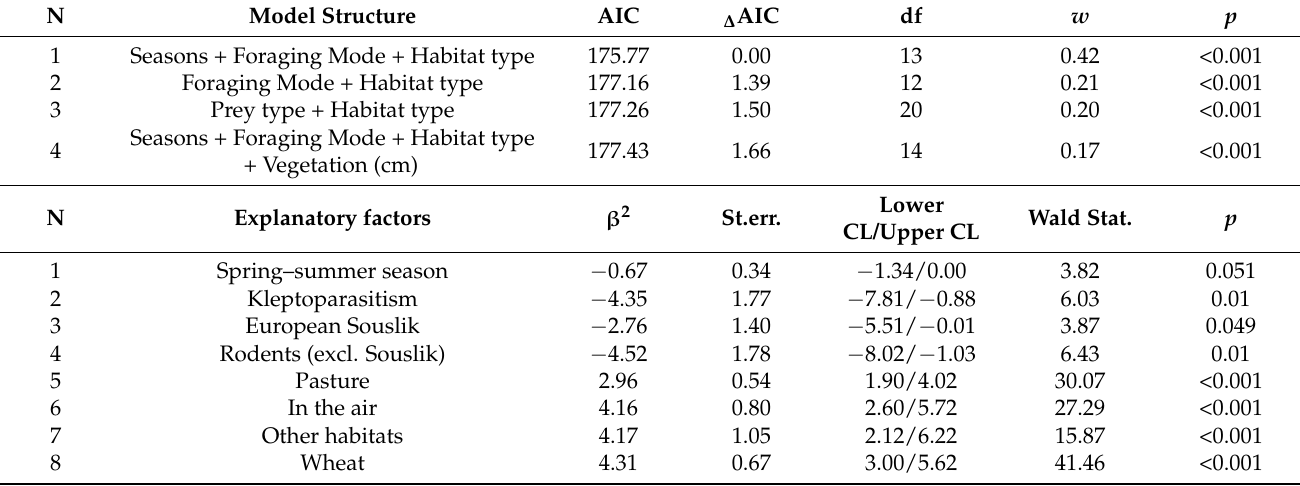
Table 3. List of GLMMs used for the analysis of the foraging pattern of non-territorial Eastern Im- perial Eagle. All models with ∆ AIC < 2 were considered the best models. The degree of freedom (df), model weight value ( w ) and probability value of each model ( p ) were also given. Parameter esti- mates ( β 2 ) ± SE, Lower (95%) and Upper CL (95%) of significant explanatory factors, their im- portance value (Wald Stat.), and a probability value ( p ) were taken from the average model.